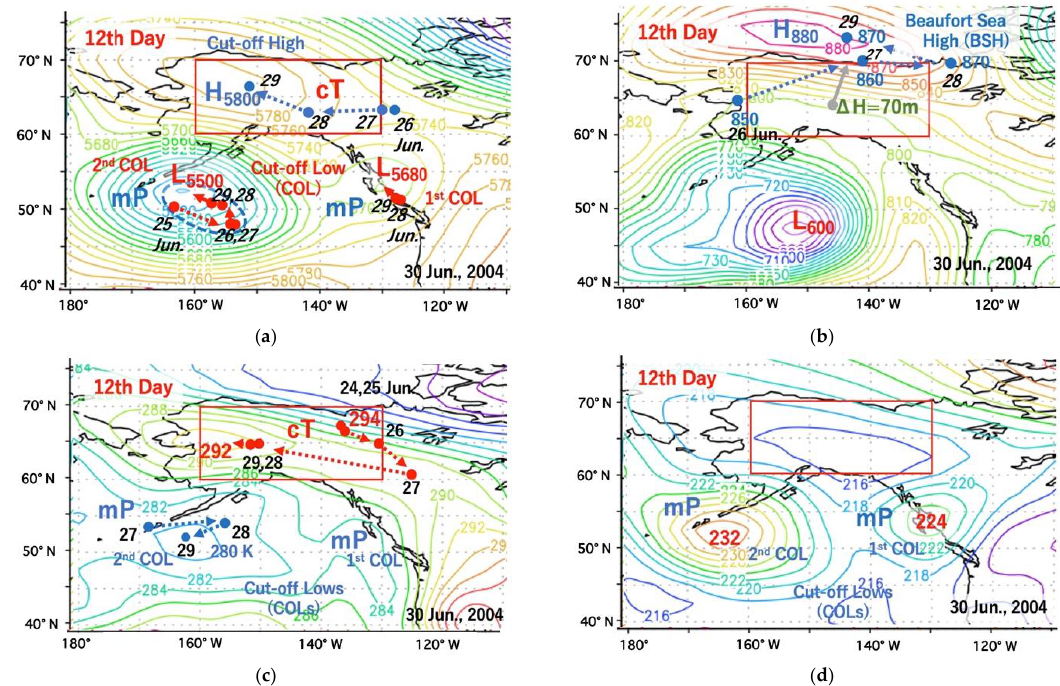
Figure 8. Fire weather conditions on 30 June (HS peak day) in Alaska. Blue dotted lines with a solid circle and an arrow at both ends indicate their positions and directions of movement of high-pressure systems and cT. Red dotted lines with a solid circle and an arrow at both ends indicate their positions and directions of movement of low-pressure systems and mP. ( a ) Weather map (500 hPa). ( b ) Weather map (925 hPa). The grey line with a solid circle and an arrow at both ends shows the height gradient (ΔH = 70 m) . ( c ) Temperature map (925 hPa). ( d ) Temperature map (200 hPa).